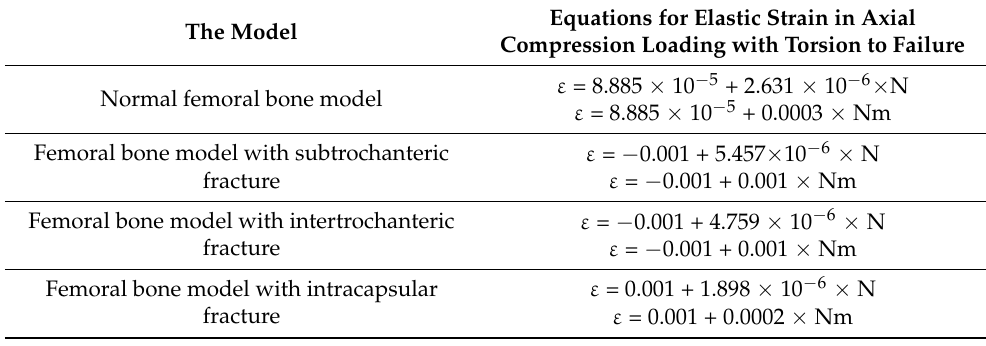
Table 8. Equations for elastic strain in axial compression loading with torsion to failure.